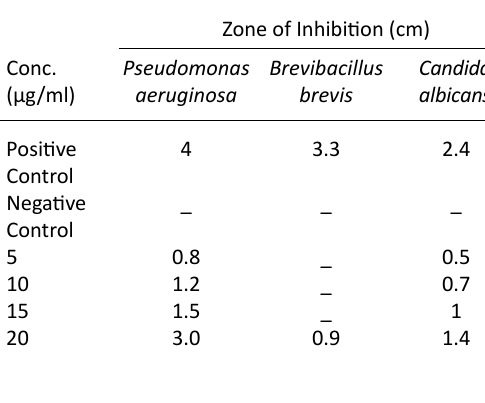
Table 1. In-vitro evaluation of antimicrobial activity of drug encapsulated SPIONs